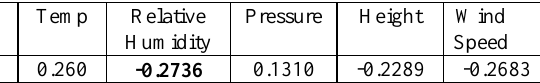
Table 3. Pearson Correlation coefficient between independent and dependent